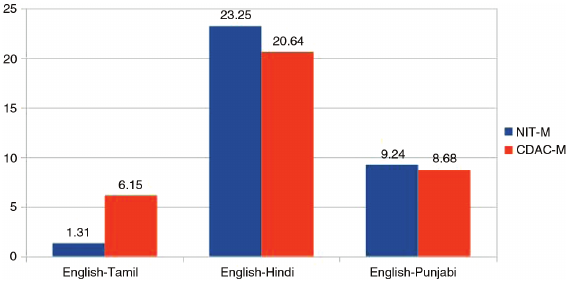
Figure 5: Comparison of BLEU Scores of NIT-M and CDAC-M